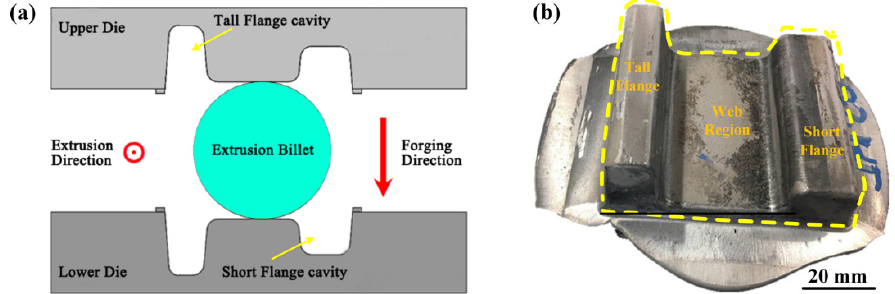
Figure 1. ( a ) Schematic of the forging process and ( b ) a picture of the forged I-beam from an extrusion billet.